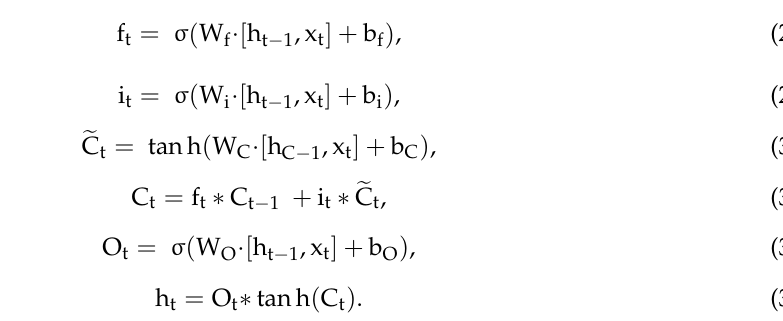
Figure 30. Diagram for Long Short-Term Memory (LSTM).